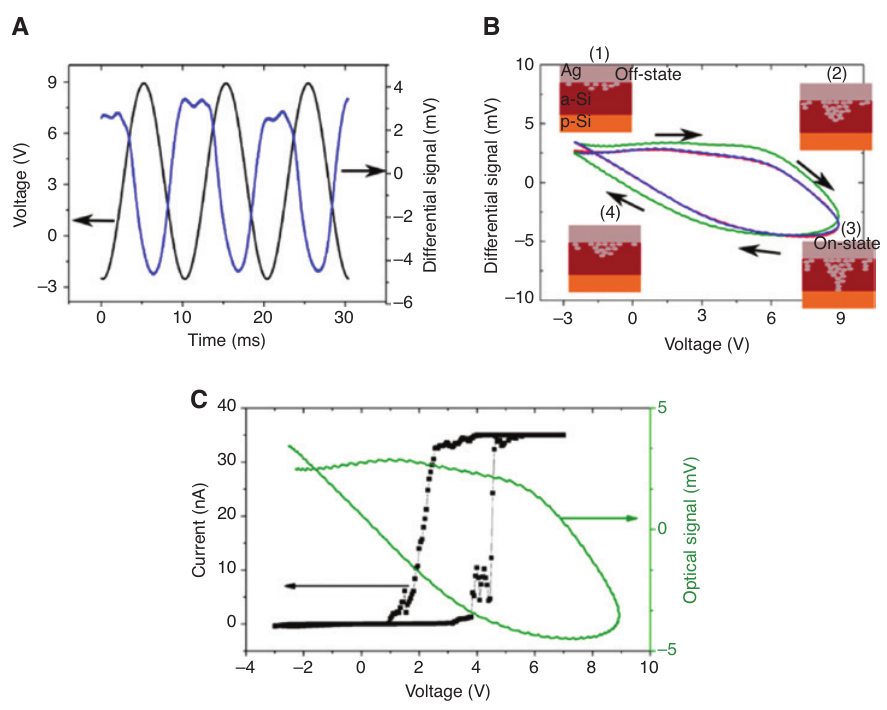
Figure 7: Modulation of an optical signal during resistive switching. (A) A sinusoidal voltage stimulation (black) results in a modulated optical signal (here represented as a differential signal, blue). The bandwidth is limited by the resistance and capacity of the device and could be significantly improved. (B) The optical modulation is schematically contributed to the growth and rupture of a filament inside the switching insulator. (C) Resistive switching (black) characteristic versus optical signal